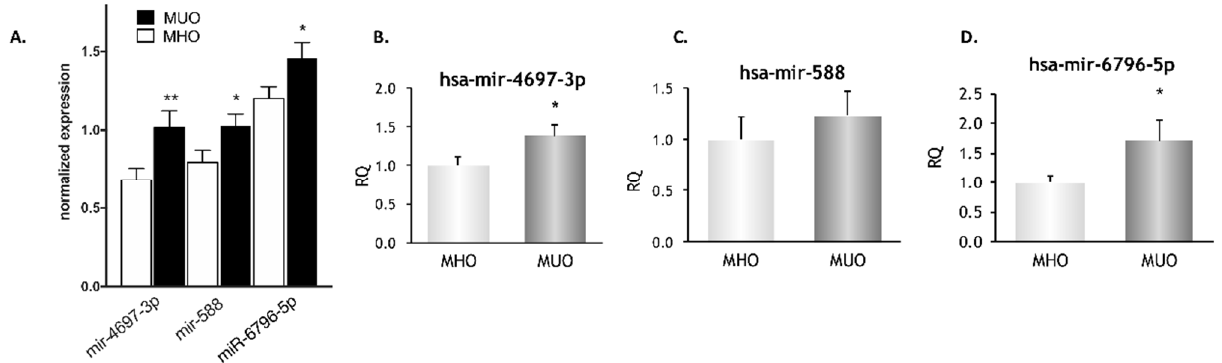
Figure 4. Validation of 3 miRNA array-predicted changes by quantitative RT-PCR (qPCR). ( A ) Microarray expression of the three selected miRNAs in MHO and MUO subjects. ( B – D ) Quantitative miRNA expression analysis of ( A ) hsa-mir-4697-3p ( B ) hsa-mir-588 and ( C ) hsa-mir-6796-5p was carried out using TaqMan probes by qPCR. * p < 0.05, ** p < 0.01.